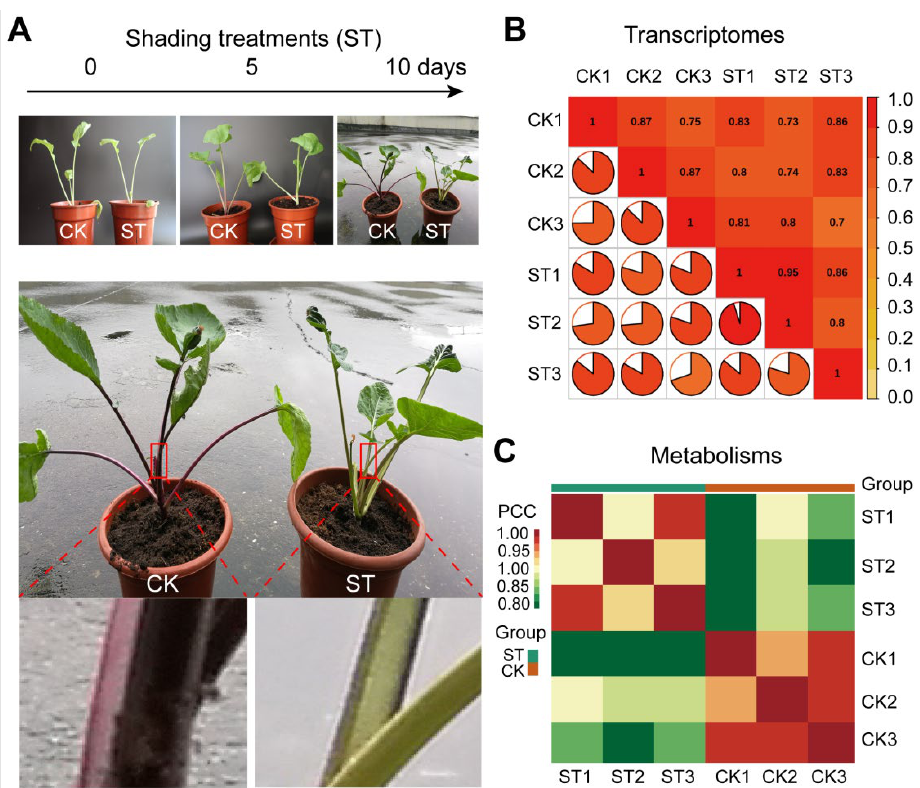
Figure 1. Transcriptome and metabolic analysis in low light treated petiole of XH1 cai-tai seedlings. ( A ) Images of XH1 exposed to low light treatments (ST) for different days and enlarged images showing the differences of anthocyanin accumulation in the petiole of XH1. Pearson correlation of biological samples for transcriptome ( B ) and metabolism ( C ). Different colors represent the ranged values of Pearson correlation coefficient between samples.